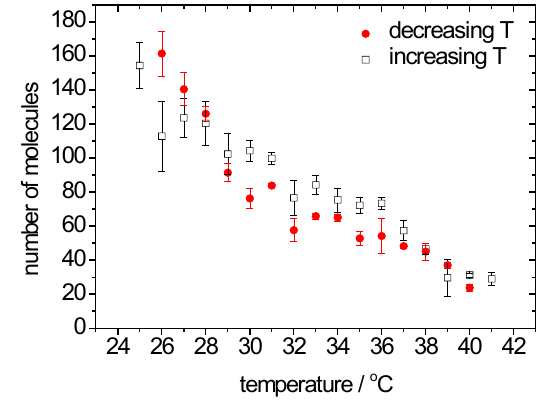
Figure 12. Average numbers of fluorescing molecules observed in a 100 nm thick pvac film on 10 areas of 26×26 µm at different temperatures.